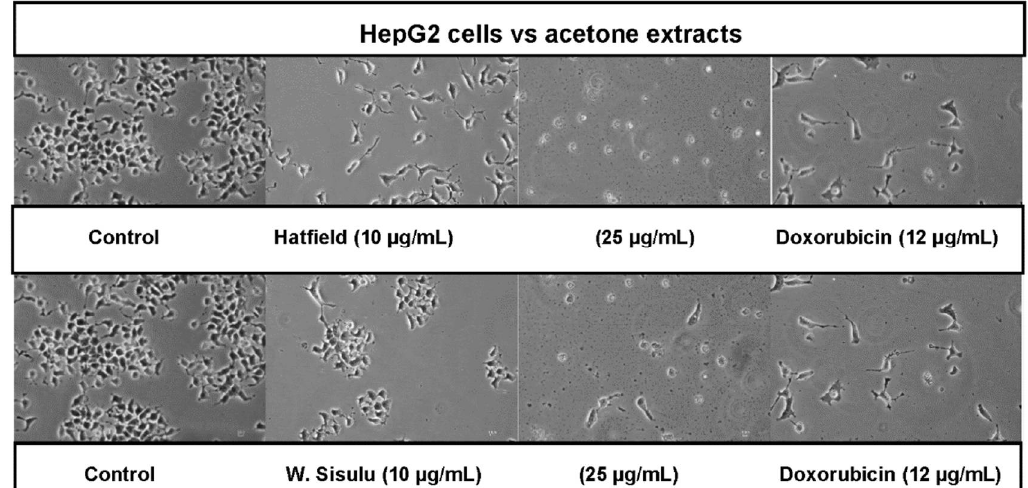
Figure 1. Morphological characterization of HepG2 cell lines treated with 10 and 25 µg/mL of Hatfield and Walter Sisulu acetone crude extracts, and 12 µg/mL doxorubicin for 48 h.